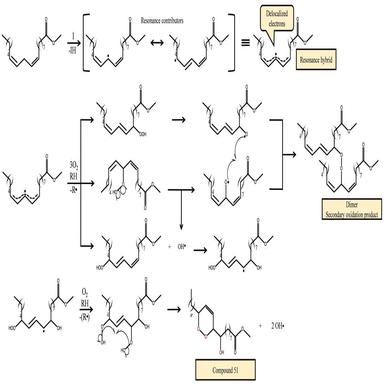
Reaction scheme of the oxidative degradation of linoleic acid to form compound 51.